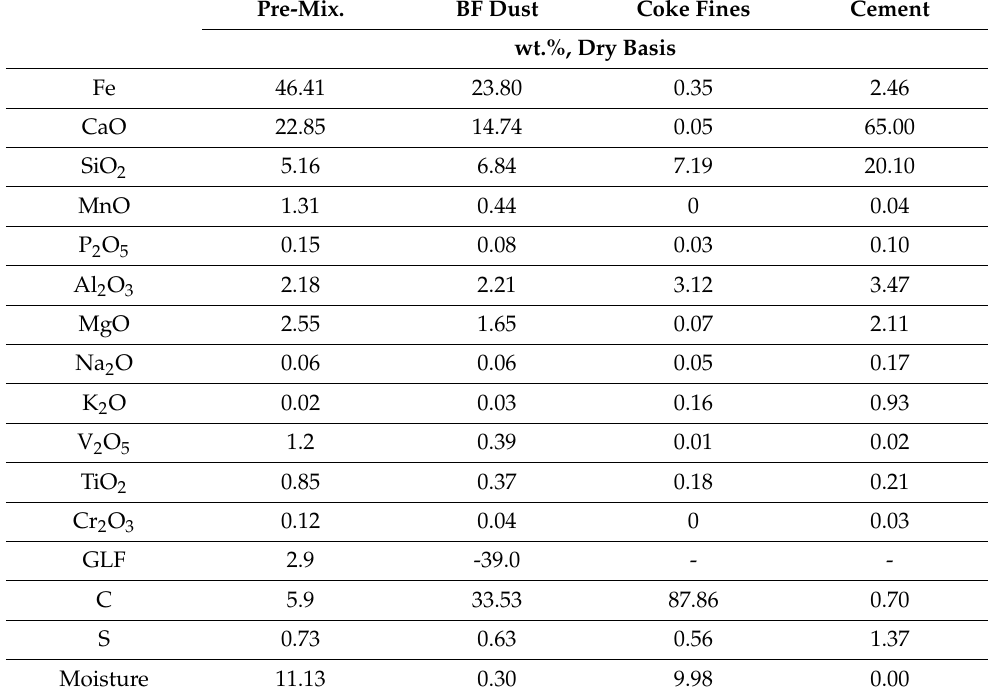
Table 1. Chemical analysis of applied